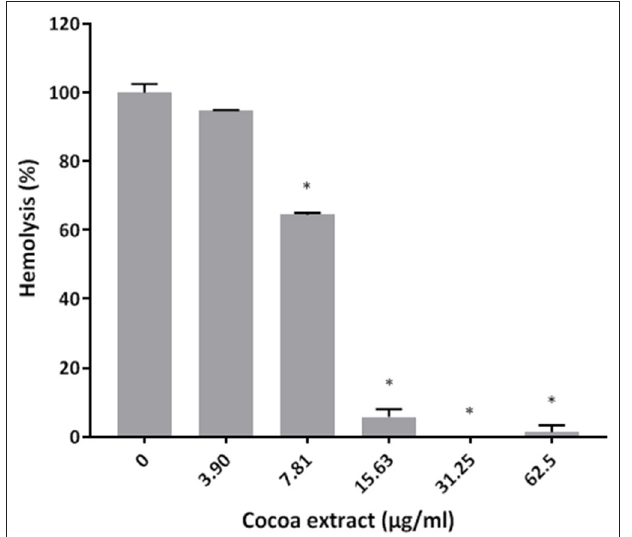
FIGURE 2 | Effect of the cocoa extract on the hemolytic activity of P. gingivalis cells. Hemolysis of sheep red blood cells was monitored by recording the absorbance at 540nm (A 540 ) following an overnight incubation at 37 ◦ C and a one-h incubation at 4 ◦ C. A relative value of 100% was assigned to hemolysis obtained in the absence of the cocoa extract. *significant inhibition ( p < 0.01) compared to the control (no cocoa extract).